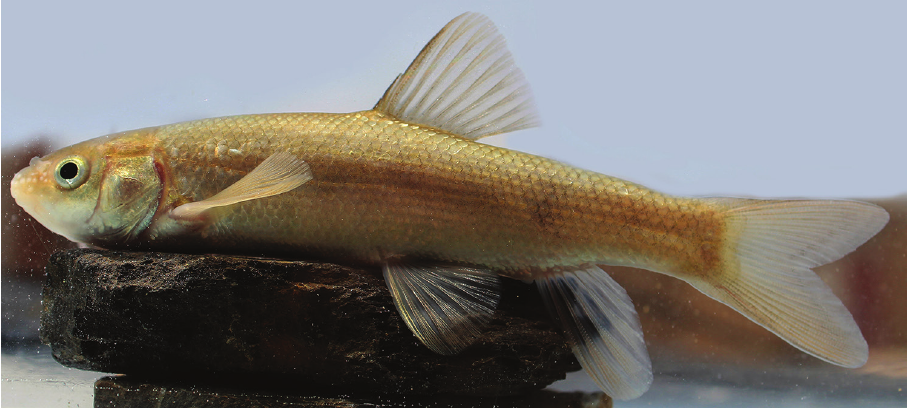
Figure 10. Live specimen of Capoeta fusca , IMNRF-UT-1065-1, SL: 124 mm, Iran: North Khorasan prov.: Near Farooj town, at segonbadan village, Qanat-e Segonbadan, Hari basin.